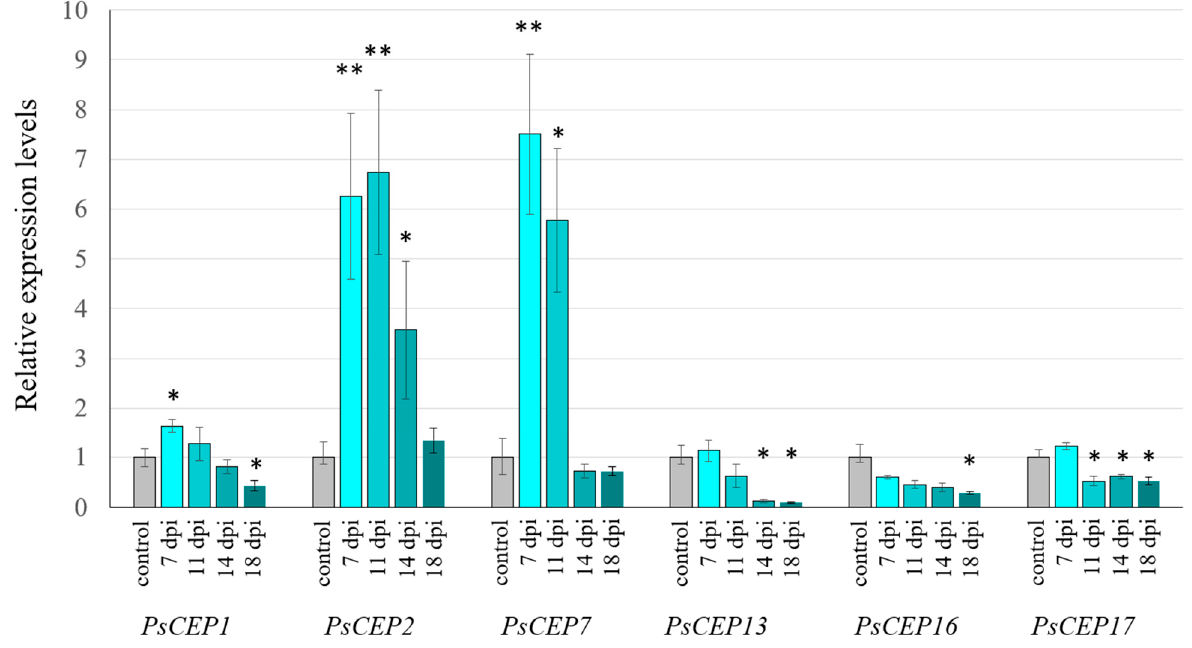
Figure 12. Expression levels of the PsCEP genes in developing nodules. “control” corresponds to non-inoculated roots, dpi–days post inoculation. Results are means ±SEM of 3-4 biological samples; Asterisks indicate statistically significant differences compared with the control (** p < 0.01; * p < 0.05) revealed by a Student’s t test. The gene expression levels were normalized to 1 against the expression found in the control roots.